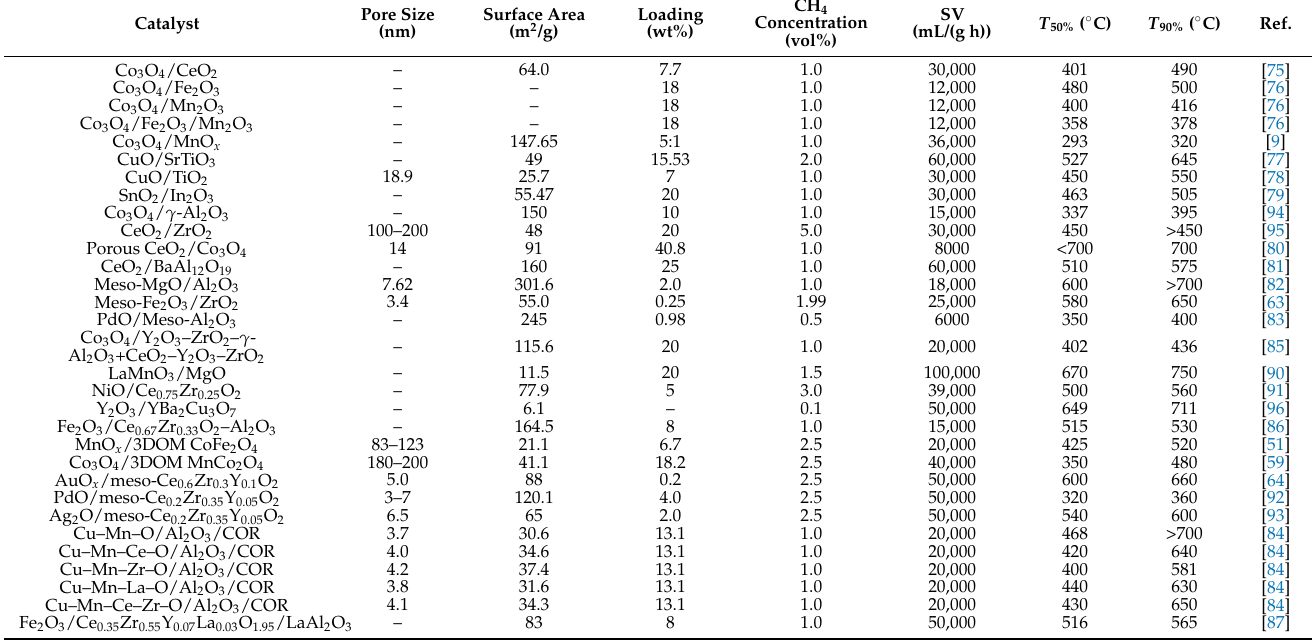
Table 2. Catalytic performance for CH 4 combustion over the ordered porous composite oxide and supported metal oxide